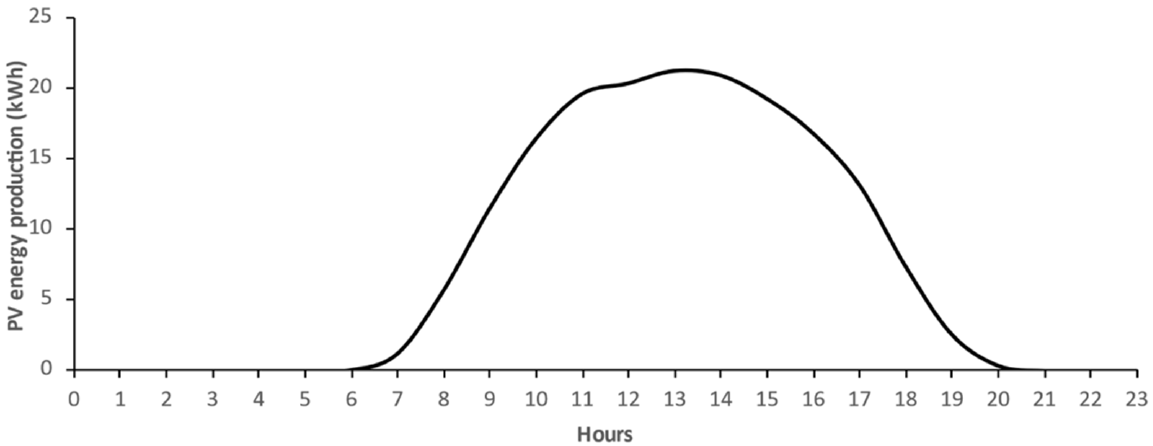
Figure 4. Distribution of average production by hours of sunlight measured from 2 March to 31 May 2022. The percentages of PV energy produced by the three groups of months mentioned above were adjusted, using the average daily values of PV energy produced and determined using the PVGIS platform as a reference. The distribution of PV energy production by daylight hours is shown in Figure